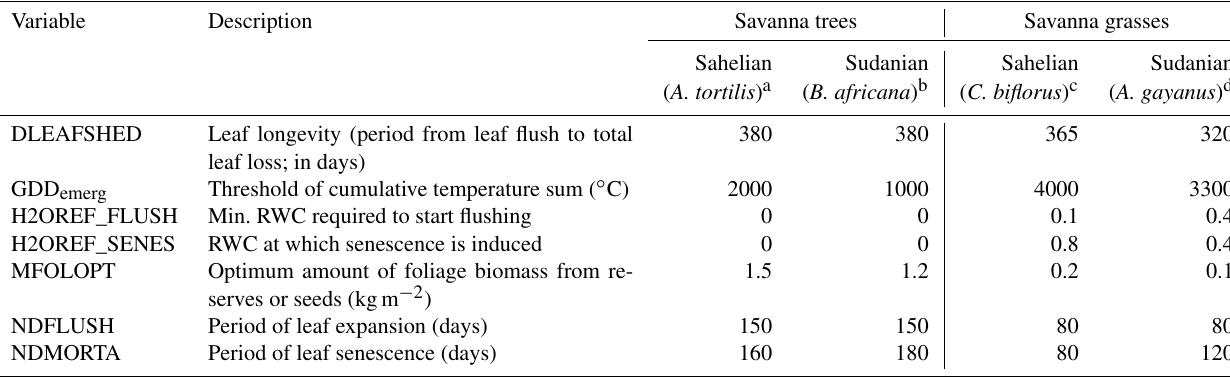
Table 4. Plant parameters related to new phenological processes used in the PSIM model for describing dynamics in natural savanna ecosys- tem types, derived from measurements at the core sites of the investigation.